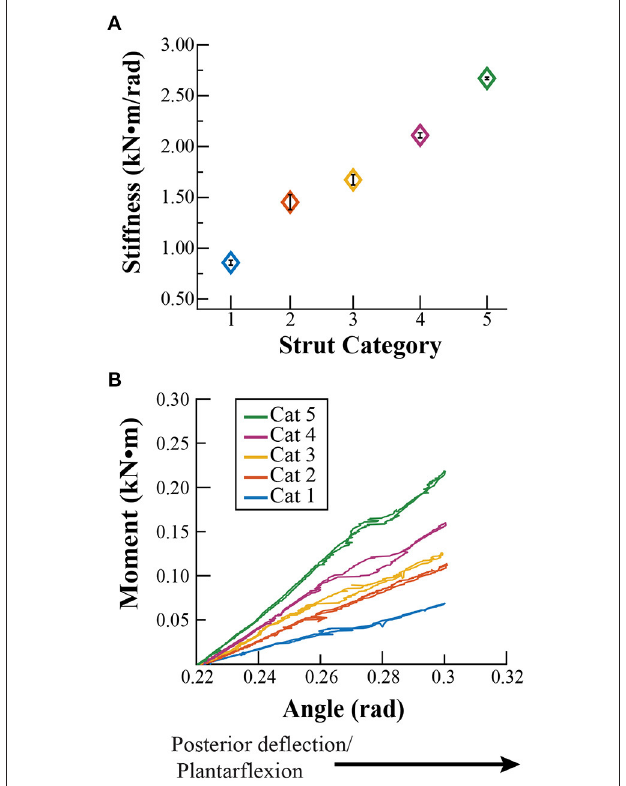
FIGURE 3 | (A) Stiffness values ( ± SD) for each strut stiffness category (Cat) with posterior deflection, calculated as the quotient of the rotational moment at an angle of 0.09rad (5 ◦ ) for Cat 1–5. (B) Representative moment versus angle relationships for each Cat during posterior deflection from an angle of − 0.22rad ( − 13 ◦ ) relative to horizontal at the beginning of the test, to − 0.32 ( − 18 ◦ ) rad at the finishing point of the test, for 0.09rad (5 ◦ ) of